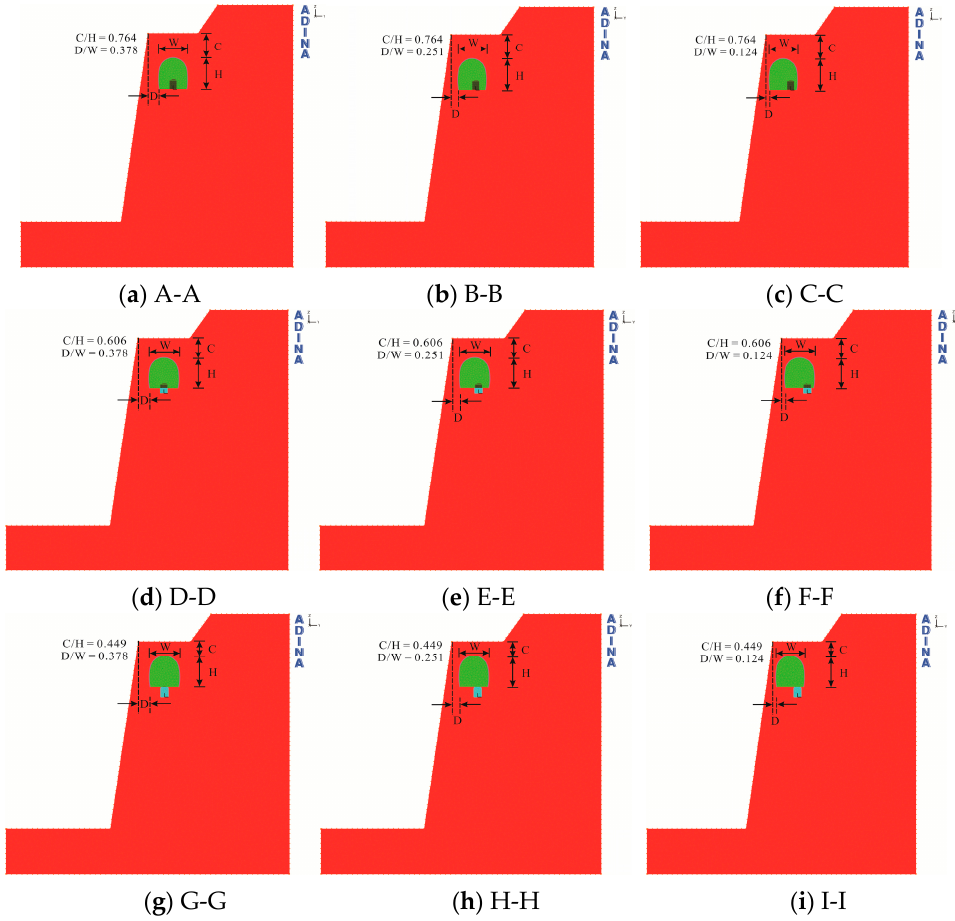
Figure 5. Schematic of the nine spatial positions for the new tunnel.